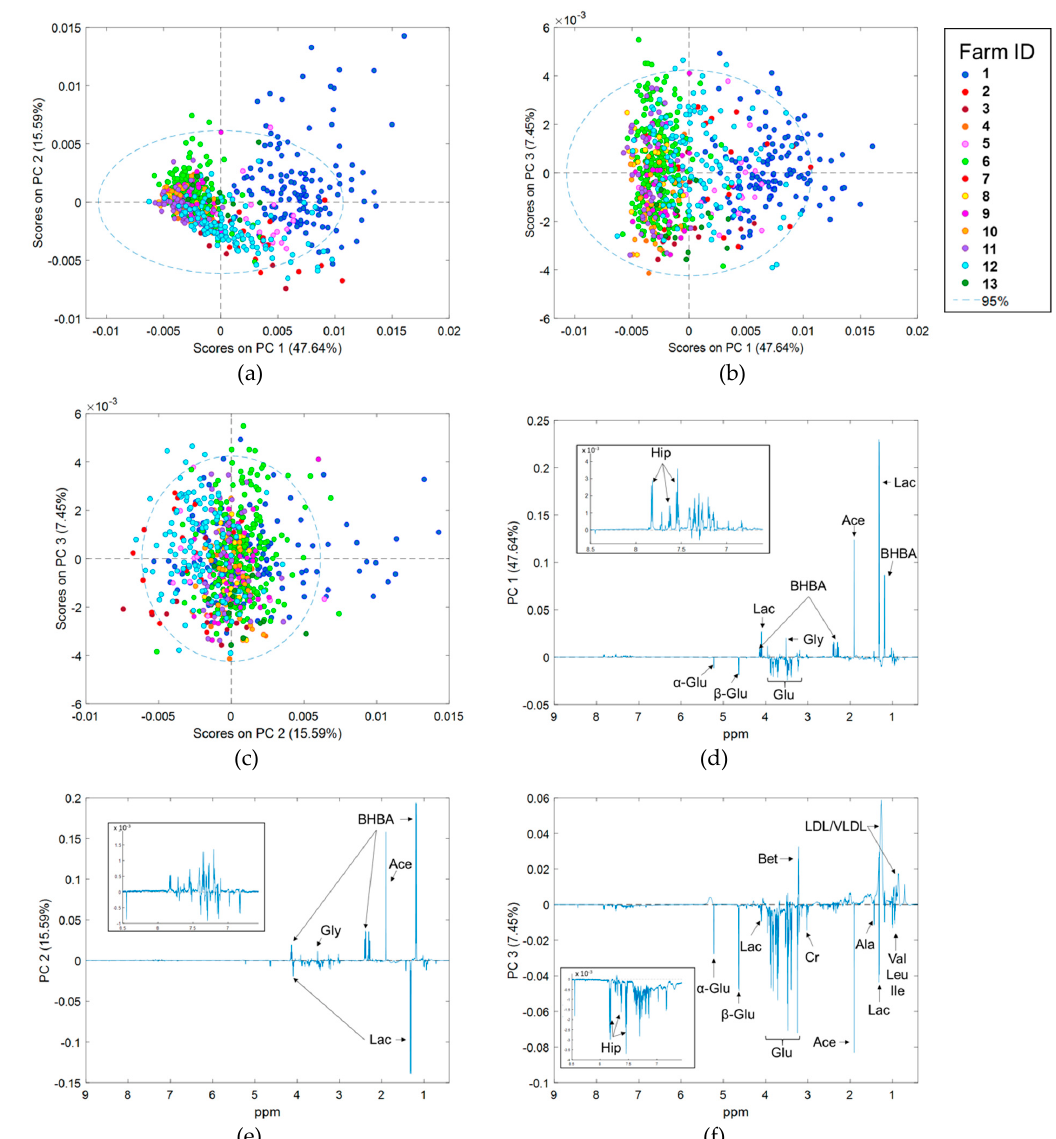
Figure 1. Results of principal component analysis (PCA) of 707 proton nuclear magnetic resonance ( 1 H NMR) spectra of serum obtained from dairy cows in early lactation; ( a ) principal component (PC) 1 vs. PC 2 scores, ( b ) PC 1 vs. PC 3 scores, ( c ) PC 2 vs. PC 3 scores, ( d ) PC 1 loadings, ( e ) PC 2 loadings, and ( f ) PC 3 loadings plots. Scores plots are colored by farm of origin. The δ 6.5 to 8.5 region of loadings plots have been magnified for clarity purposes. α -Glu = α glucose, Ace = acetate, Ala = alanine, β -Glu = β glucose, Bet = betaine, BHBA = β hydroxybutyrate, Cr = creatine, Glu = glucose, Gly = glycine, Hip = hippurate, Ile = isoleucine, Lac = lactate, Leu = leucine, Val = valine, VLDL/LDL = Very low density lipoprotein and low density lipoprotein.